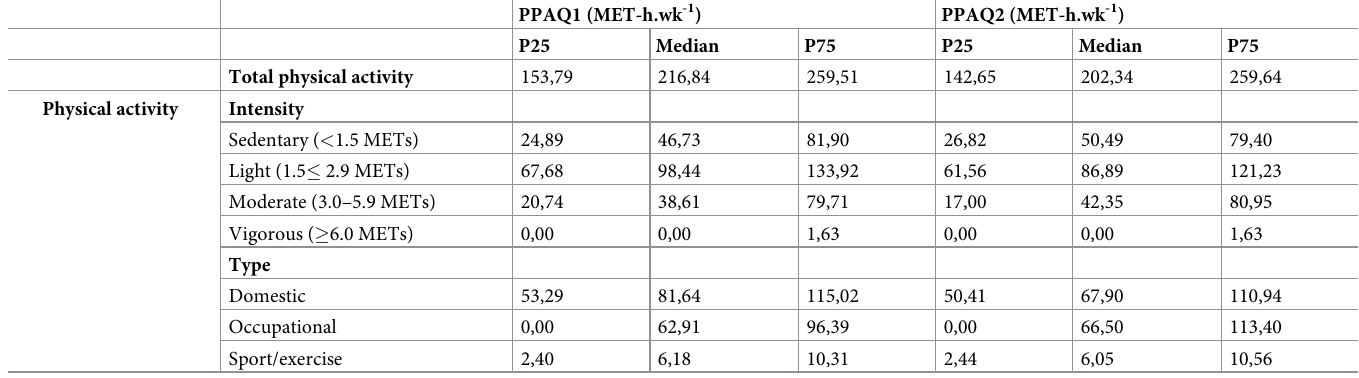
Table 3. Median of the PPAQ1 and PPAQ2 questionnaires (MET-h.wk -1 ) for total physical activity and for physical activity as a function of intensity and type (n = 184). PPAQ1 (MET-h.wk -1